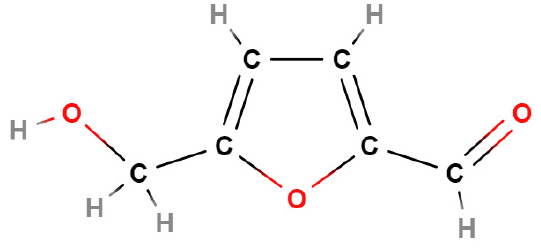
Figure 10. Structure of 5-HMF (C 6 H 6 O 3 ) .